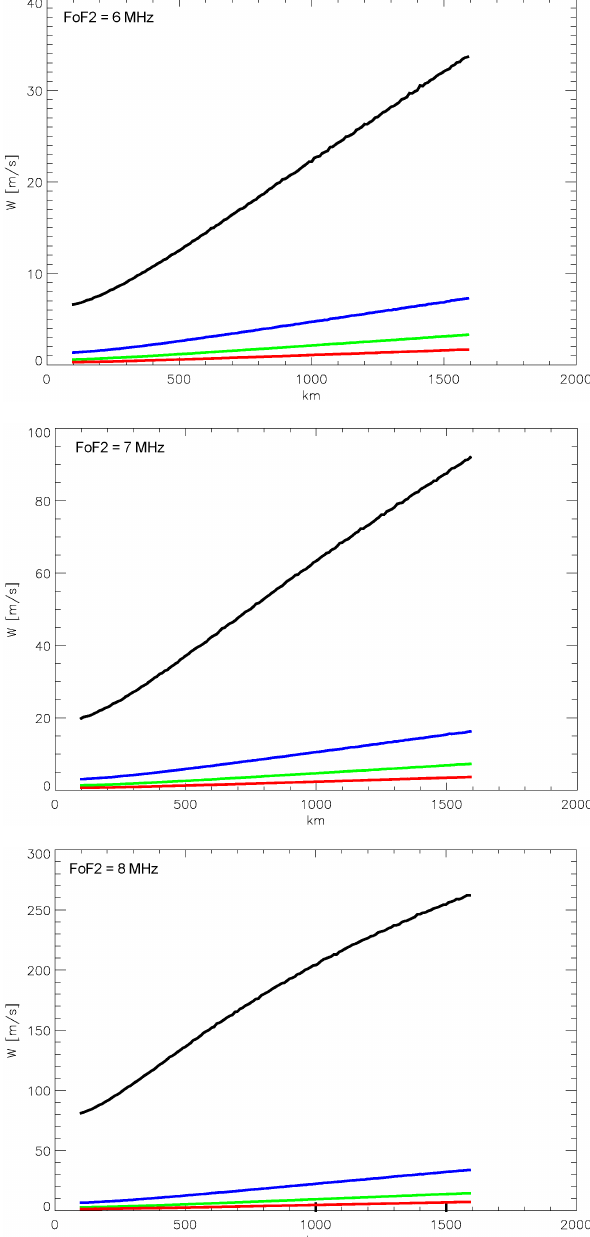
Fig. 8. Spectral width enhancement due to decorrelation, averaged over 23 orbits for a radar frequency of 9MHz (black), 12MHz (blue), 14MHz (green), 16MHz (red) and a maximum plasma fre- quency of 6MHz (top), 7MHz (middle) and 8MHz (bottom). Z ∞